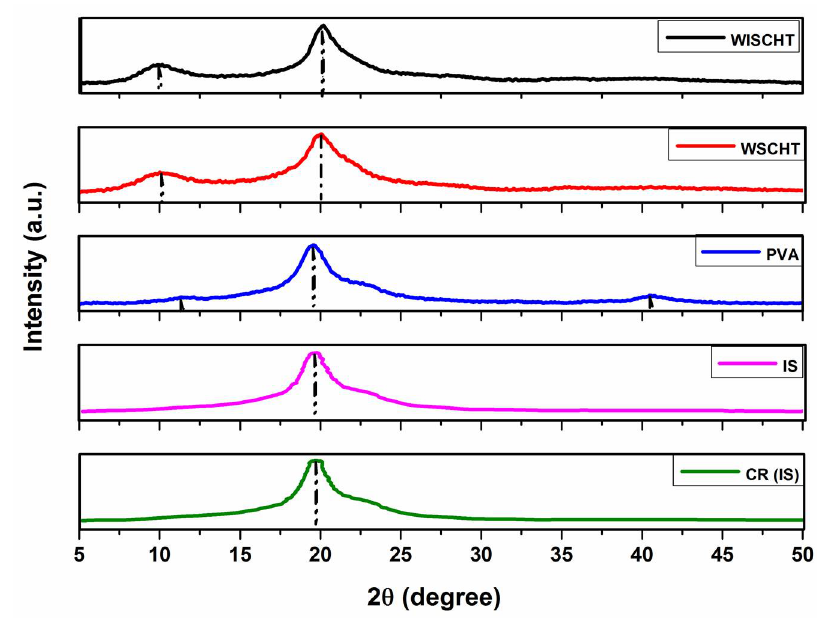
Figure 7. X-ray Diffraction (XRD) of prepared samples.